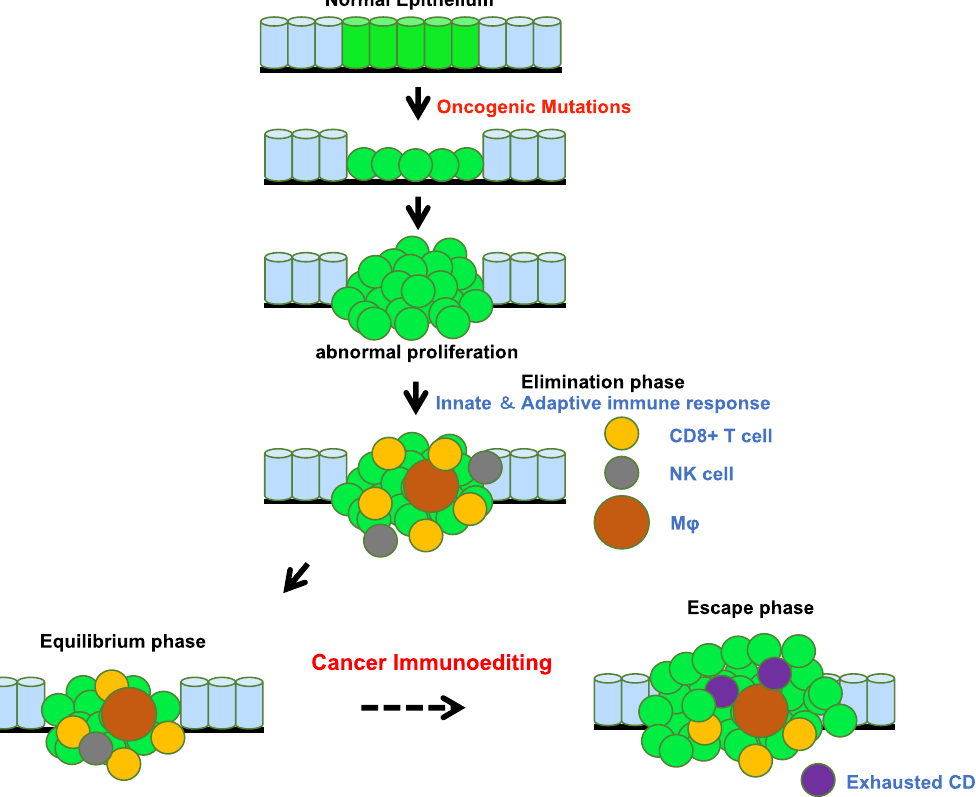
Figure 4. Tumor evolution and immunoediting. The accumulation of oncogenic mutations initiates tumor evolution. The immune surveillance system, including cytotoxic CD8 positive T cells, natural killer cells, and macrophages, recognize tumor-associated neoantigens presented by MHC molecules on antigen-presenting cells. The balance between signals from the tumor microenvironment and the immune system shifts during tumor elimination, equilibrium, and escape.